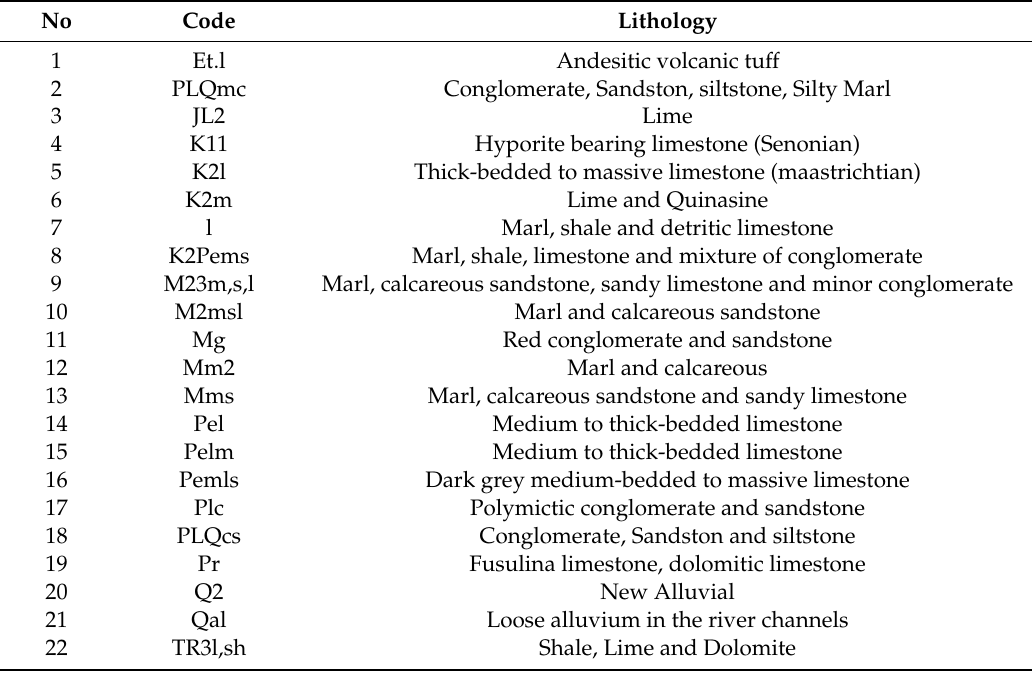
Table 1. Lithological description of the study